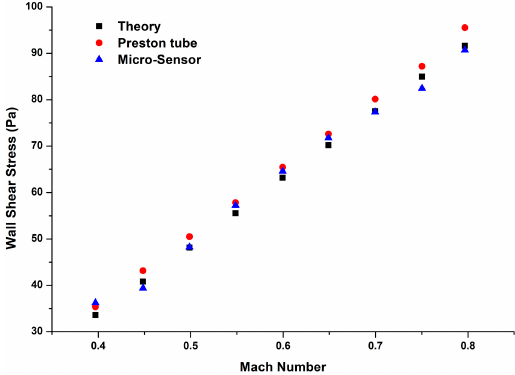
Figure 10. Comparisons of wall shear stress obtained by (9), the Preston tube, and the micro-sensor.